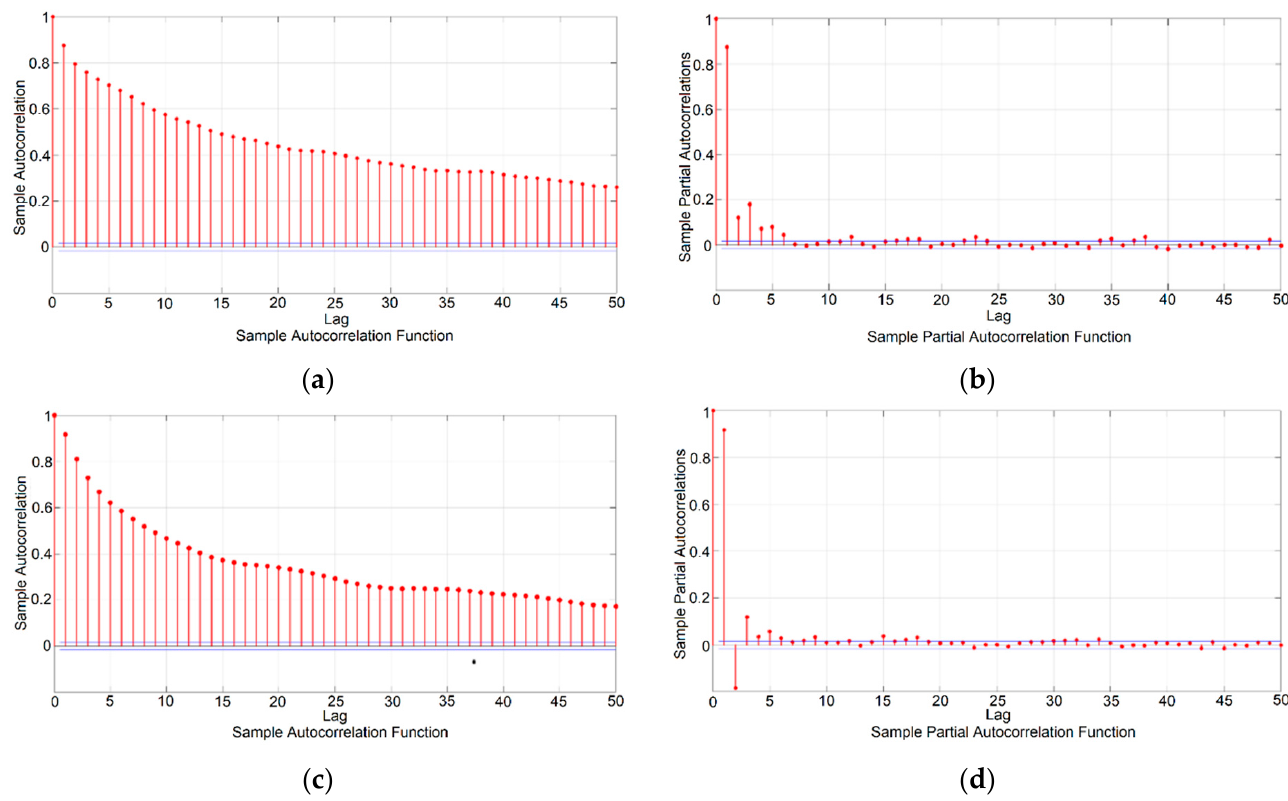
Figure 5. Autocorrelation function (ACF) and partial autocorrelation function (PACF) plots for daily discharge data of catchment Fal at Tregony ( a , b ) and Teifi at Glanteifi ( c , d ), respectively.